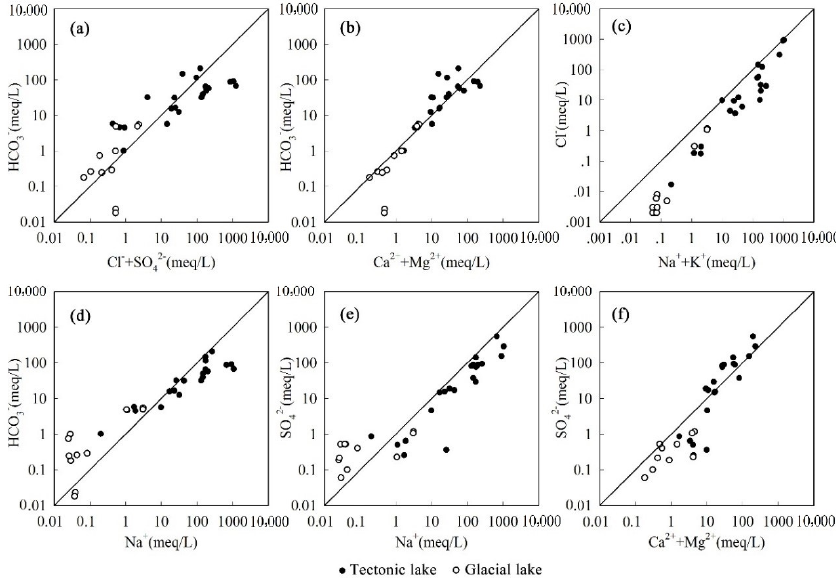
Figure 5. Major ion ratio of the tectonic lakes and the glacial lakes in Tibetan Plateau. The ratio of HCO 3− to Cl − +SO 42− ( a ), HCO 3− to Ca 2+ +Mg 2+ ratio ( b ), Cl − to Na + +K + ratio ( c ), HCO 3− to Na + ratio ( d ), SO 42− to Na + ratio ( e ), SO 42− to Ca 2+ +Mg 2+ ratio ( f ).